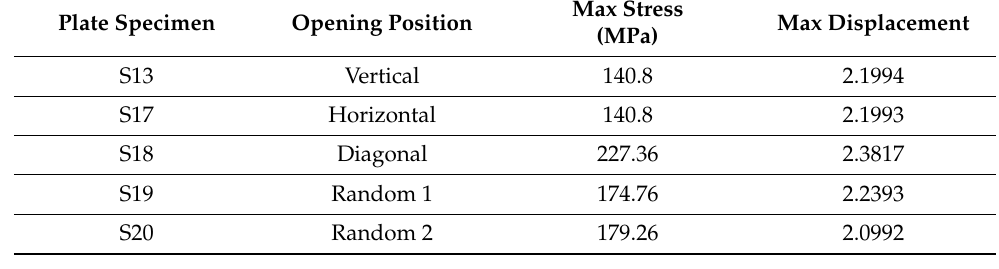
Table 3. Steel plate specimens with differing opening positions and their respective maximum stress and displacement investigated by ANSYS.